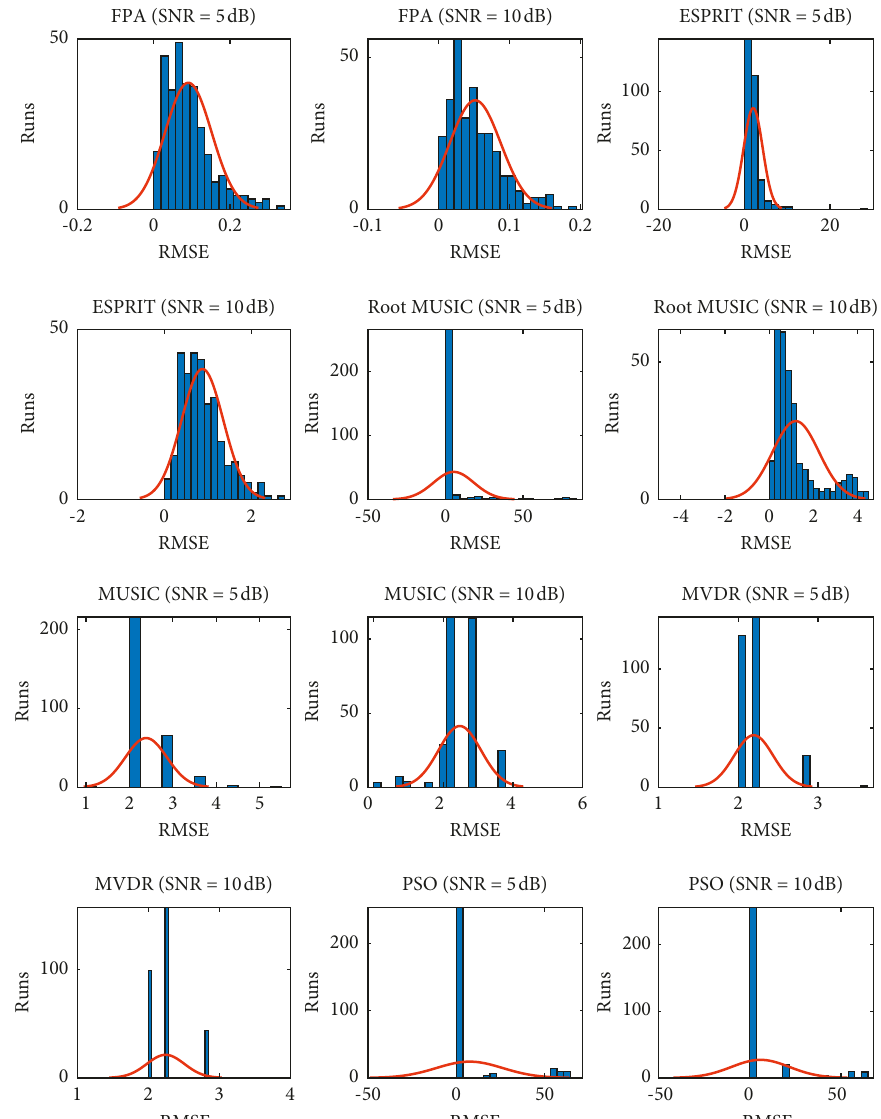
Figure 17: Histogram analysis of RMSE for two